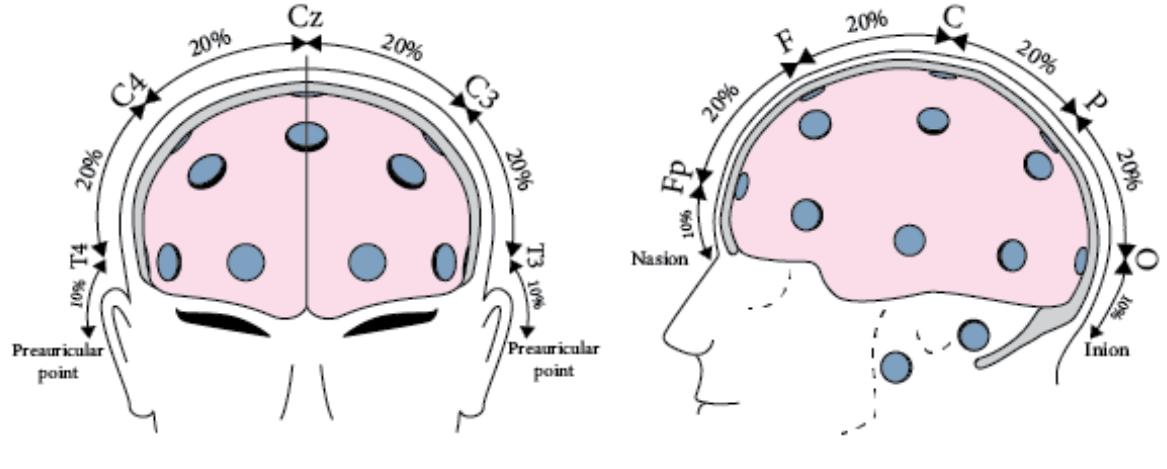
Figure 4. Frontal and sagittal plane views of the electroencephalography electrode placement points in the 10-20 electrode measurement system